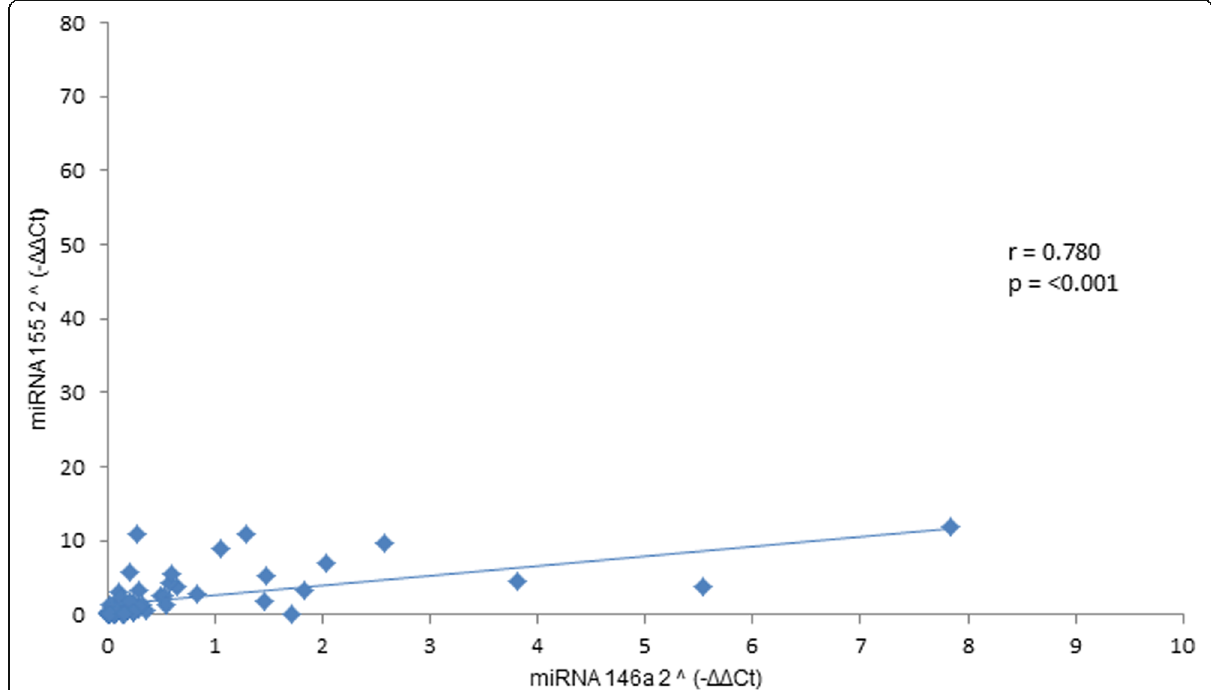
Fig. 1 Positive correlation between miR-146a and miR-155 expression in patients with BD